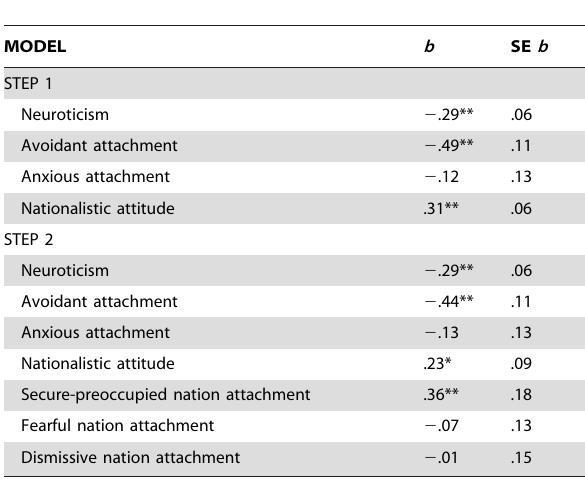
Table 9. Association of Nation Attachment with Flourishing (Study